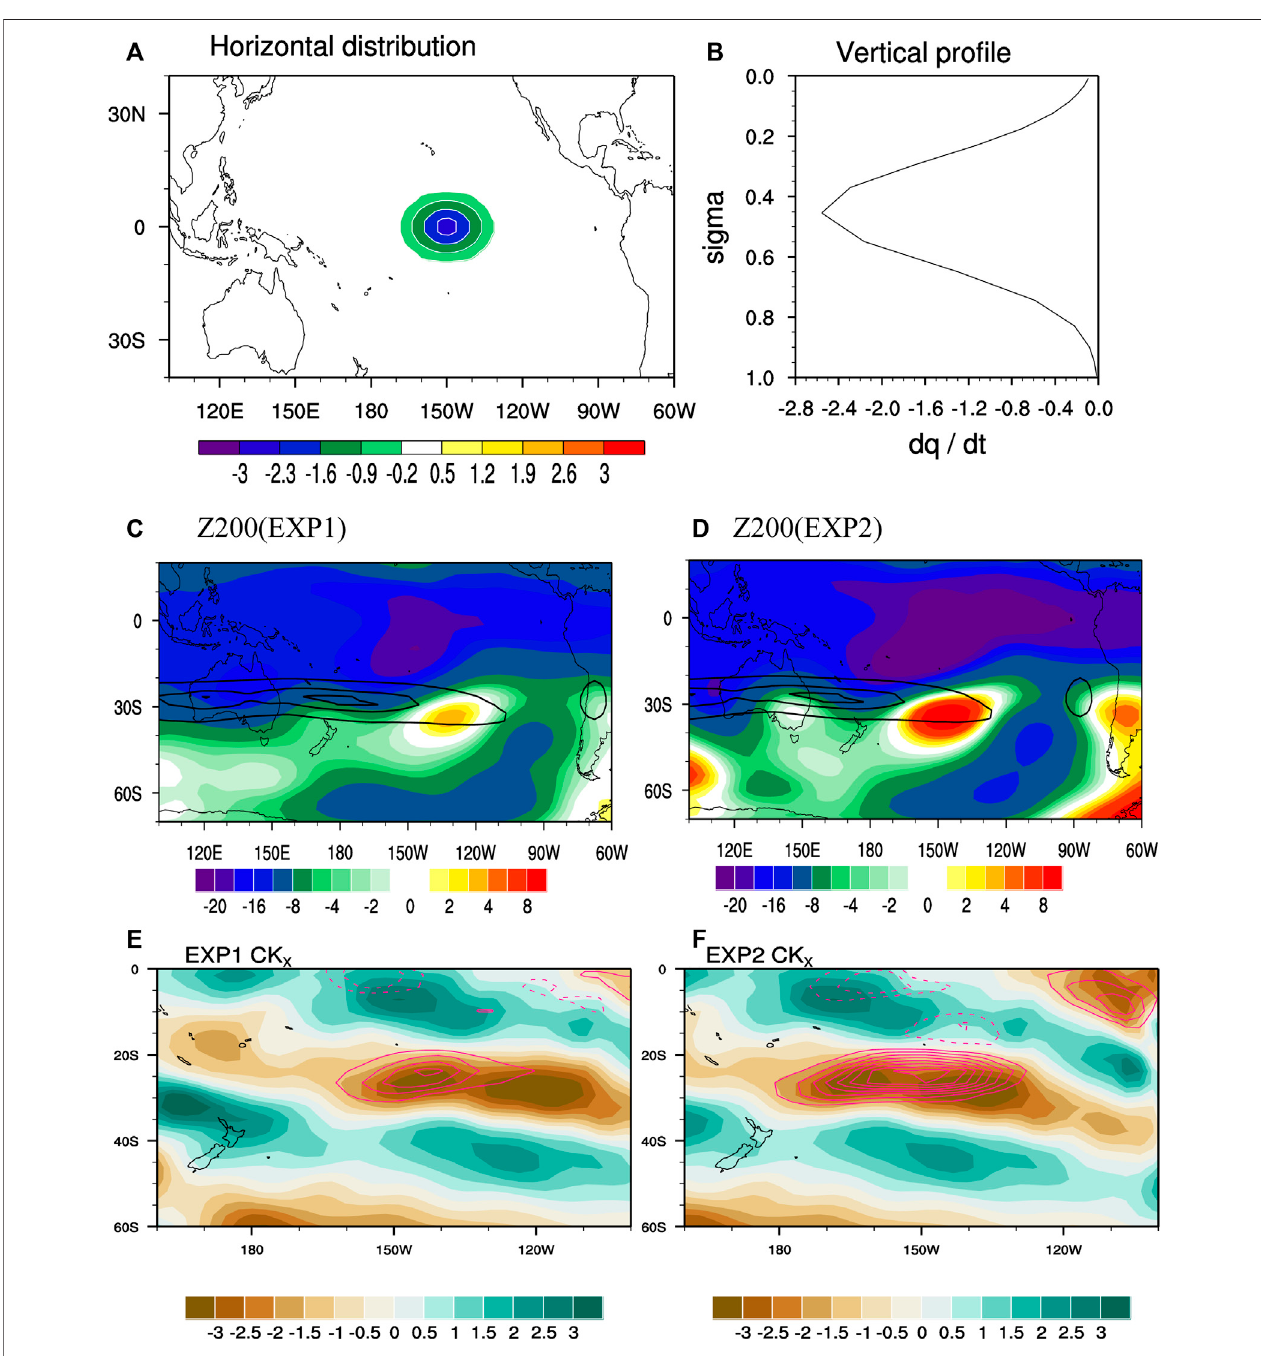
FIGURE 5 | (A) Horizontal distribution and (B) vertical pro fi le of imposed atmospheric diabatic heating (K day − 1 ) in the central Paci fi c in the two LBM experiments. The climatological zonal wind (contour lines, m/s) and the 200-hPa geopotential height (shading, m) responded to the heating sources in (C) EXP1 and (D) EXP2. CK x (contour lines; m 2 /s 3 ) and z (cid:1) u z (shading, s − 1 ) in (E) EXP1 and (F) EXP2. Adapted from Wang et al. (2022). © American Meteorological Society. Used with permission. x